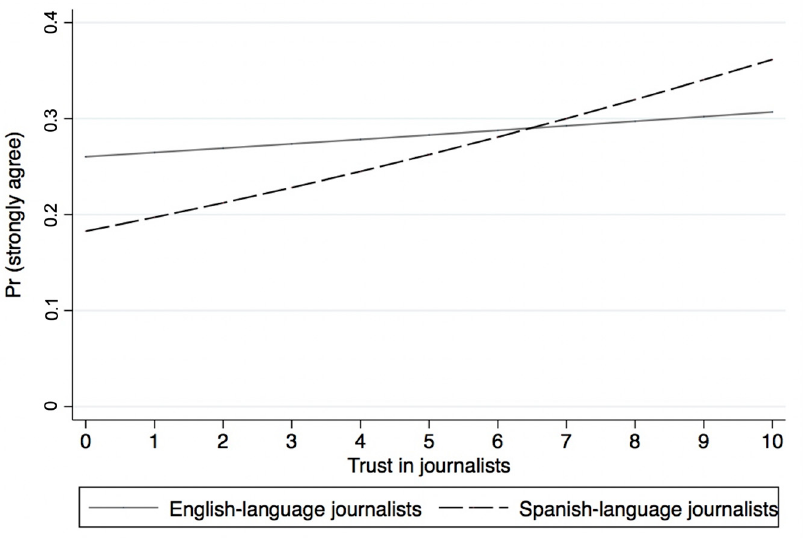
Figure 3. Predicted probabilities of reporting “strongly agree” on officials providing clear information on the location of testing sites.